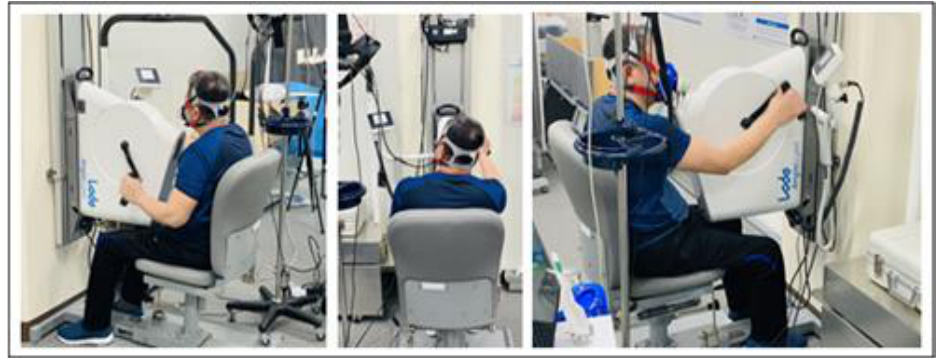
Figure 1. Maximal graded exercise using arm ergometer.